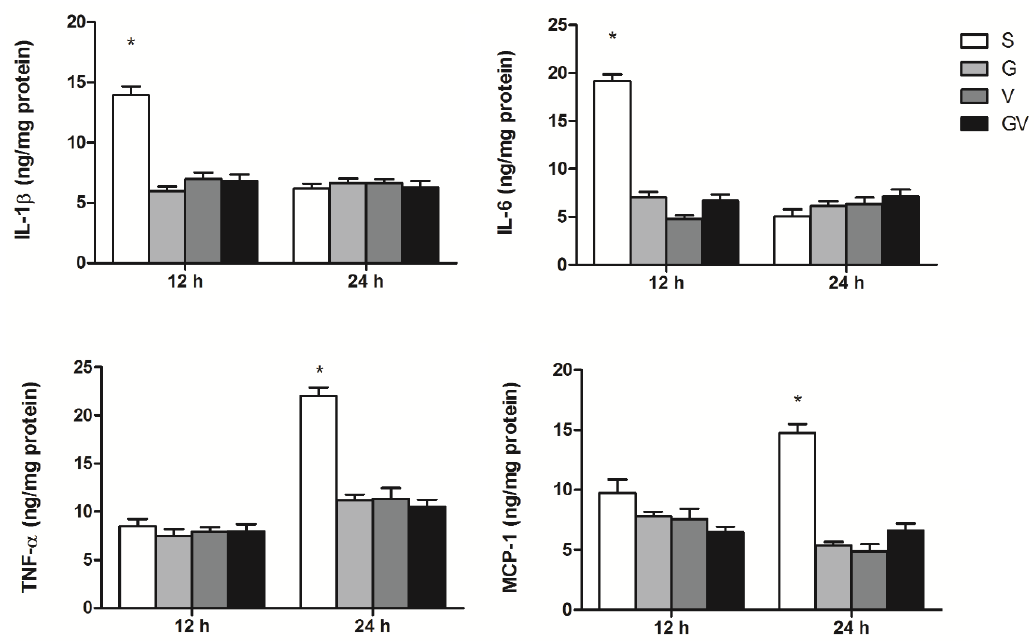
Figure 3. Concentrations of inflammatory mediators in ileum tissues after cecal ligation and puncture at two time points. IL, interleukin; TNF, tumor necrosis factor; MCP, macrophage chemoattractant protein. The groups are described in the legend of Figure 1 ( n = 8 in each group). Data are presented as the mean ± SEM. Differences among groups at the same time point were analyzed by a one-way analysis of variance using Tukey’s post hoc test. * Significantly differs from the other groups at the same time point ( p < 0.05).